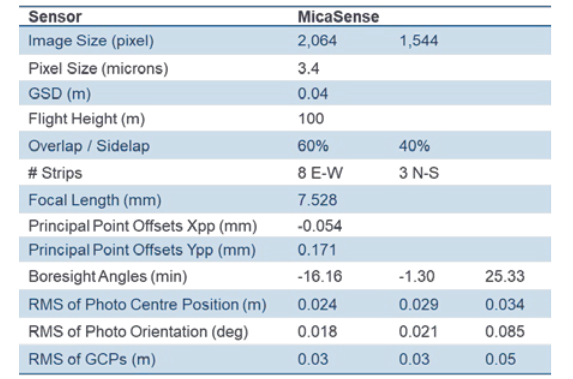
Table 1: Calibration Results, Flight 1